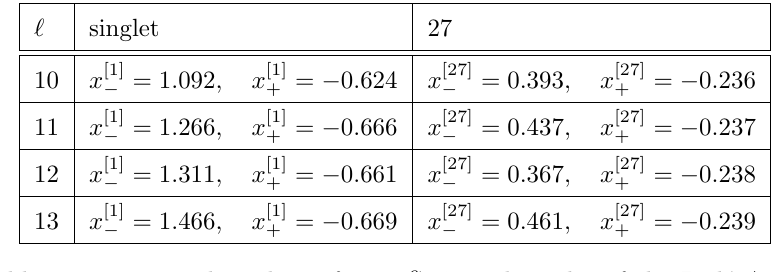
Table 3 . Table summarising the values of x = (cid:11) s eq. (6.16), considering the full amplitude at orders ‘ = 10 through 13 for the singlet and the 27